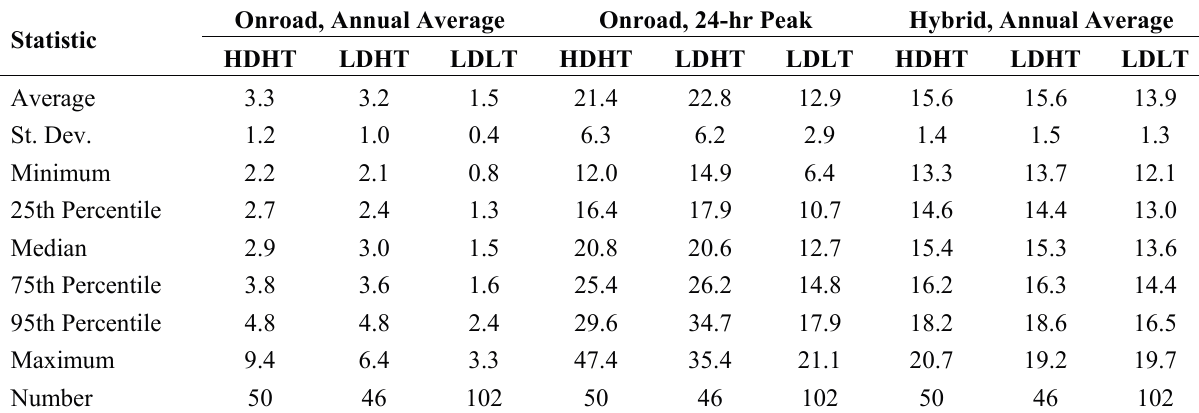
Table 2. Statistics of PM 2.5 concentrations (µg/m 3 ) predicted at home of NEXUS participants, classified by exposure group (HDHT = high diesel/high traffic; LDHT = low diesel/high traffic; LDLT = low diesel/low traffic). The hybrid annual average includes on-road, area, point and regional